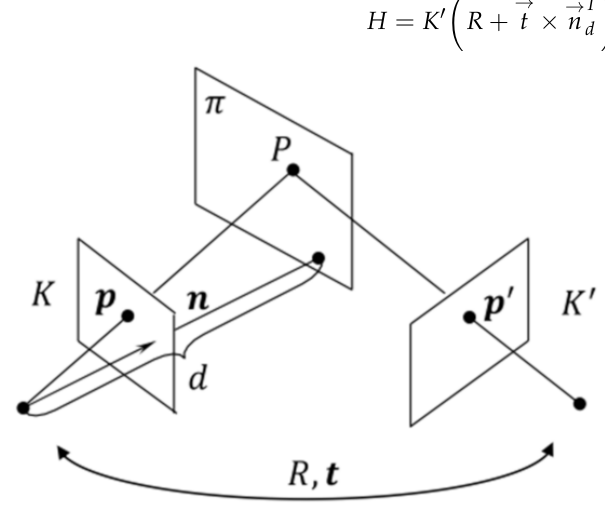
Figure 6. The parameter in the homography matrix.